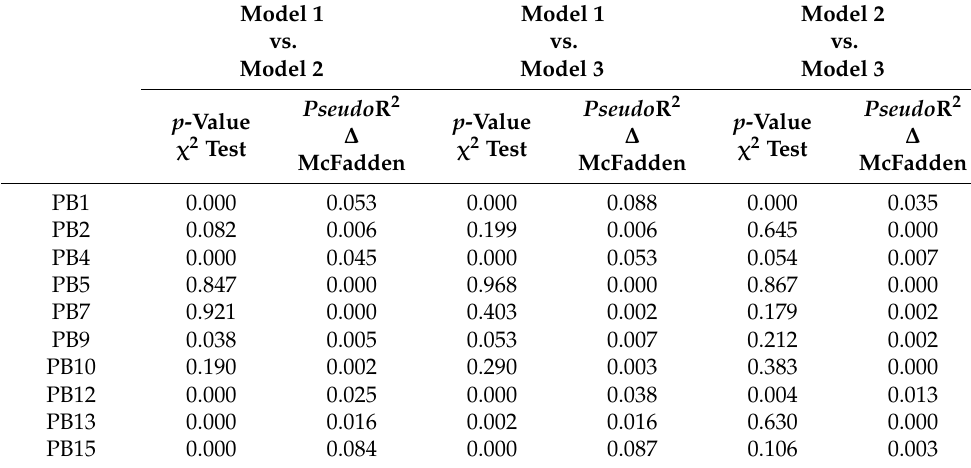
Table 4. Chi-square tests and changes in McFadden’s pseudo R 2 for DIF detection.